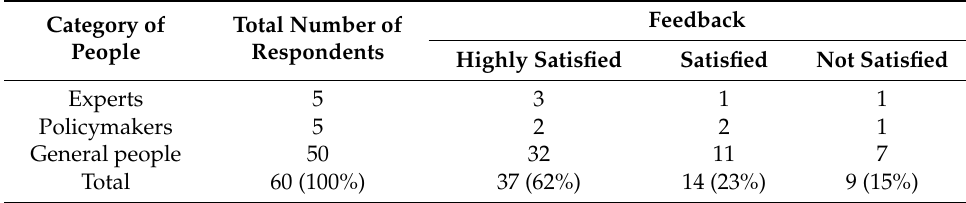
Table 5. Summary of feedback on flood vulnerability results acquired from a different category of people during the field